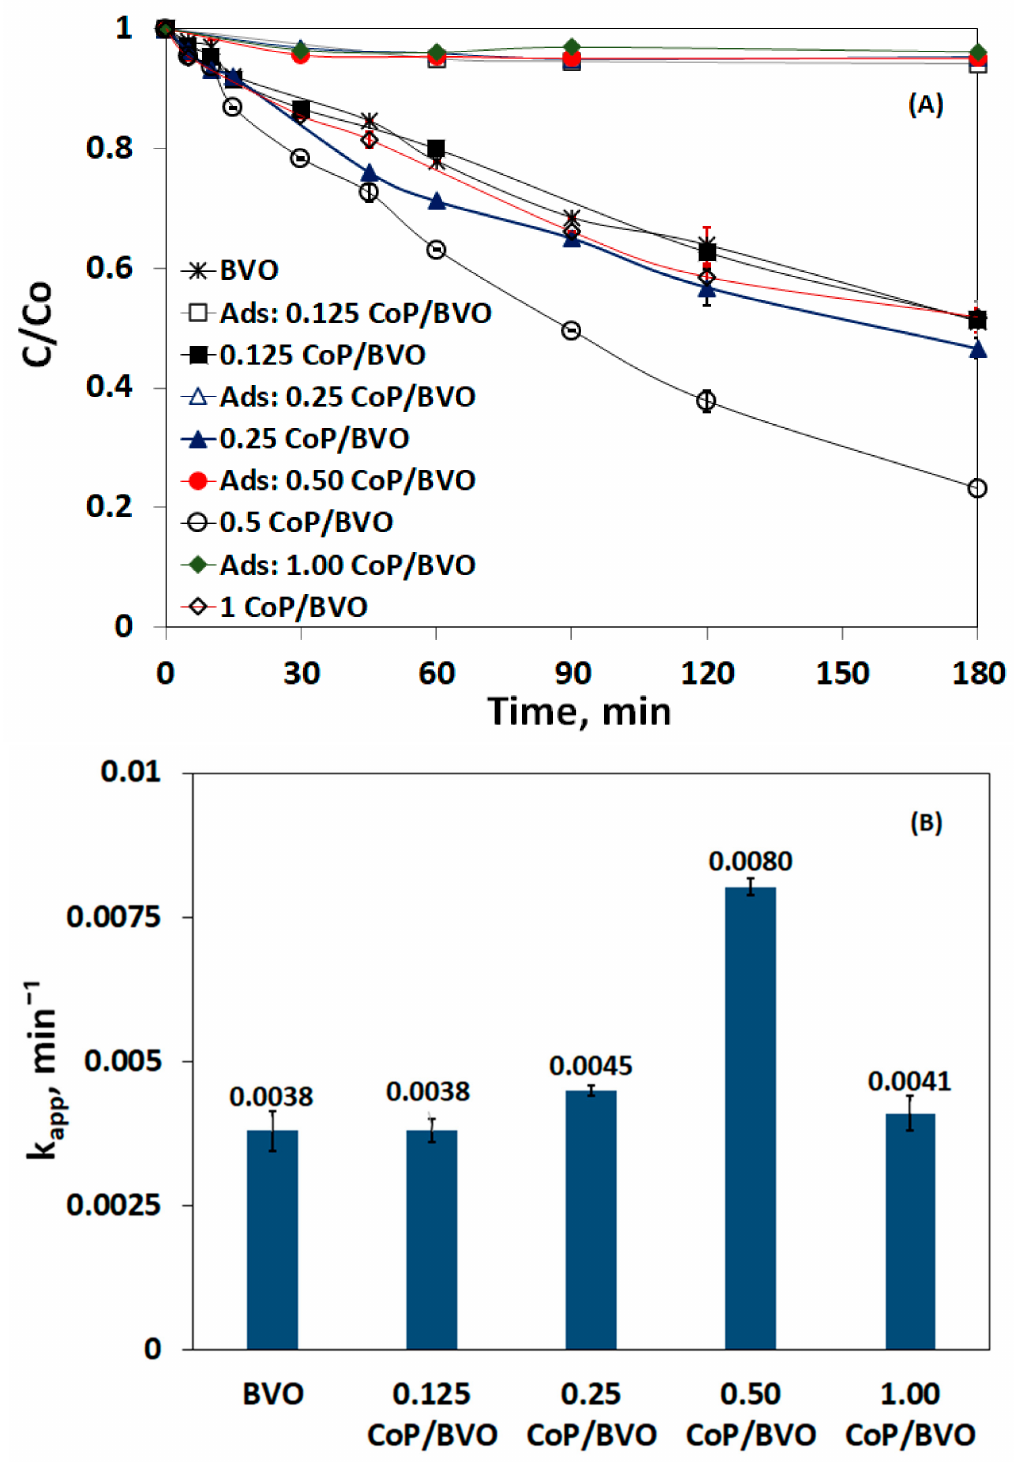
Figure 4. ( A ) Effect of CoP content (0–1.00 wt.% CoP) on the degradation of SMX over CoP/BVO photocatalysts. [SMX] = 500 µ g/L and [wt.% CoP/BVO] = 500 mg/L, pH = 5.5, UPW. ( B ) Apparent rate